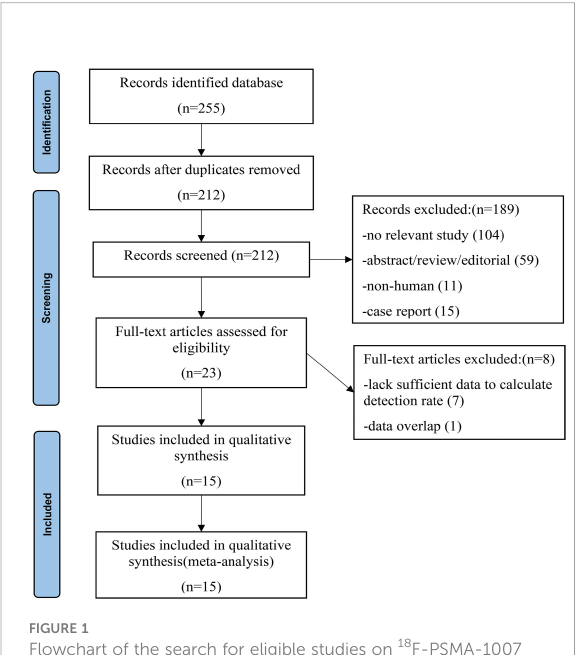
FIGURE 1 Flowchart of the search for eligible studies on 18 F-PSMA-1007 PET/CT in patients of prostate